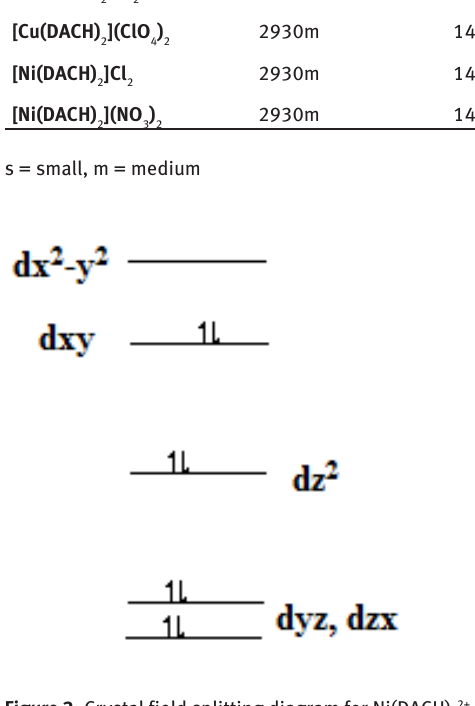
Figure 3: Crystal field splitting diagram for Ni(DACH) 22+